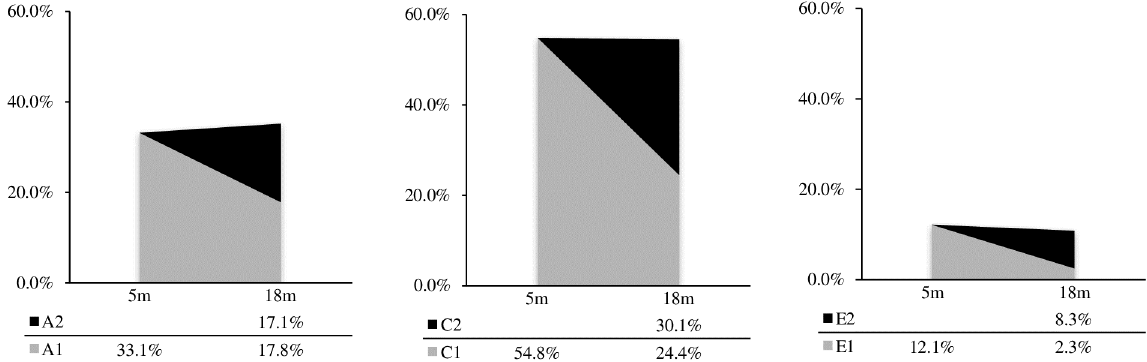
Fig 1. Standardized varianceestimatesof genetic, shared and nonshared environment latent factors associated with negative emotionality at 5 and 18 months of age. Persistence of effects are indicatedby A1, C1 and E1 factors still influencing negativeemotionalityat 18 months. Innovationeffects are indicatedby A2, C2 and E2 coming onlineat 18 months. Percentages add to 100% for each time point.